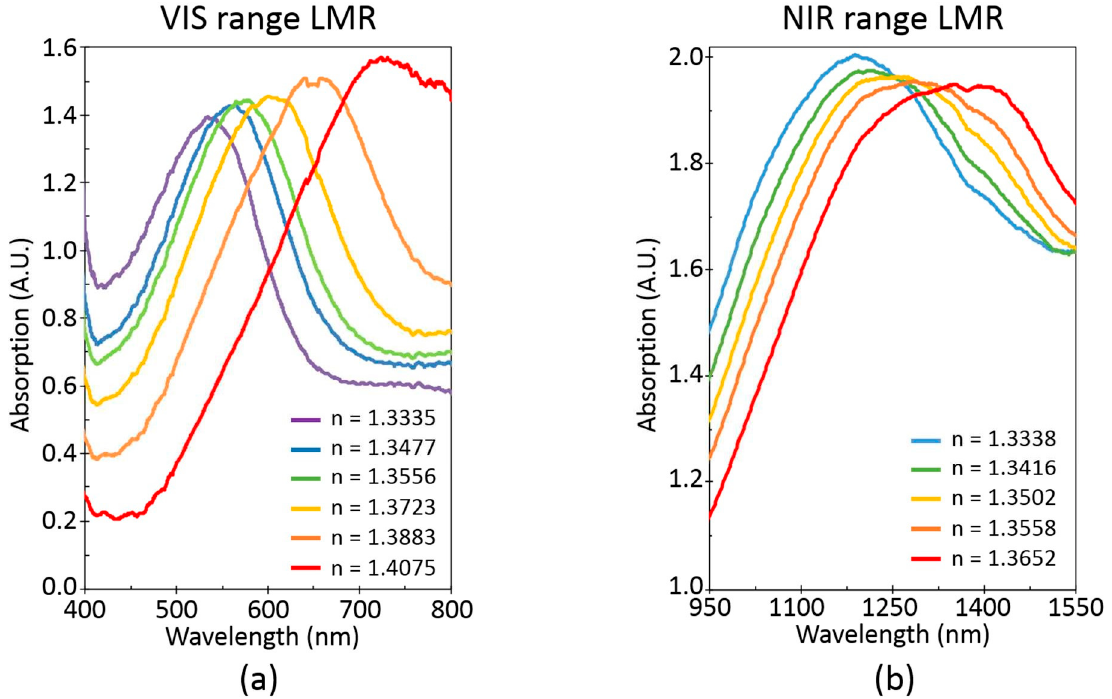
Figure 2. Absorption spectra observed for the ( a ) thinner CuO film and ( b ) thicker CuO film coated fibers when they are immersed in different refractive index